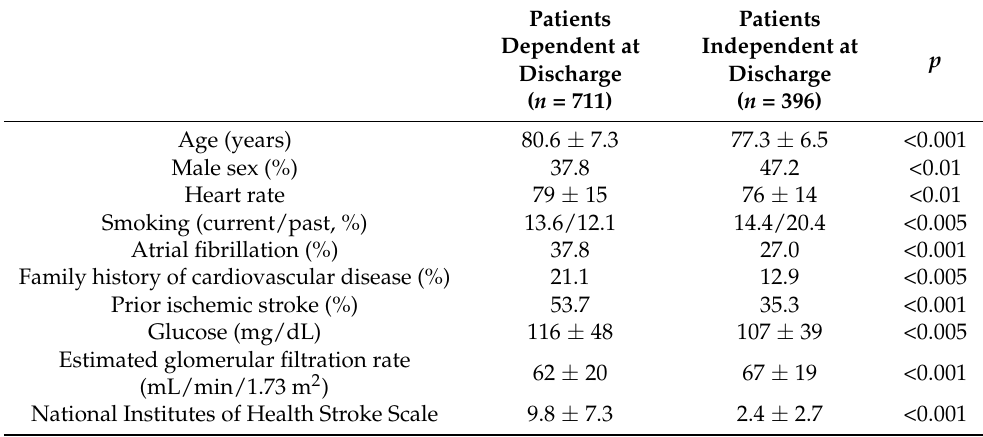
Table 2. Significant differences between patients who were dependent at discharge (modified Rankin Scale 2–5) and those who were independent at discharge (modified Rankin Scale 0–1).